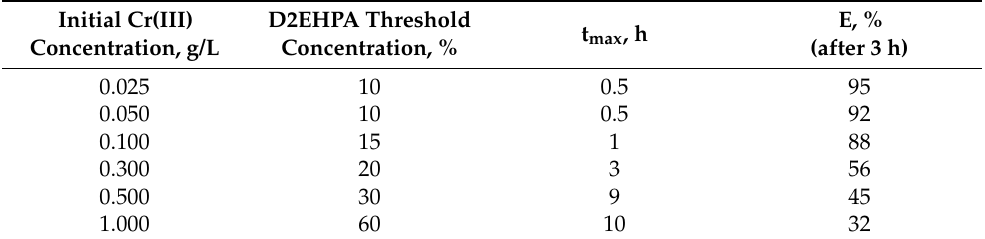
Figure 2. Relationship of D2EHPA threshold concentration in membrane phase to the initial Cr(III) ion concentration in feed phase. Table 3. Selected D2EHPA threshold concentrations and time of the maximum Cr(III) ions pertraction in SLM for different initial concentrations of Cr(III)